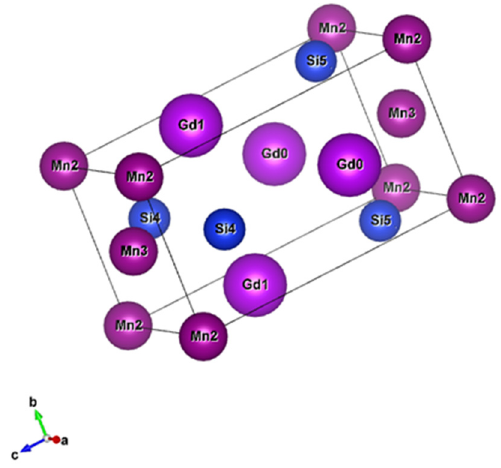
Figure 1. Crystal structure of the GdMnSi intermetallic compound, plotted with VESTA [21].